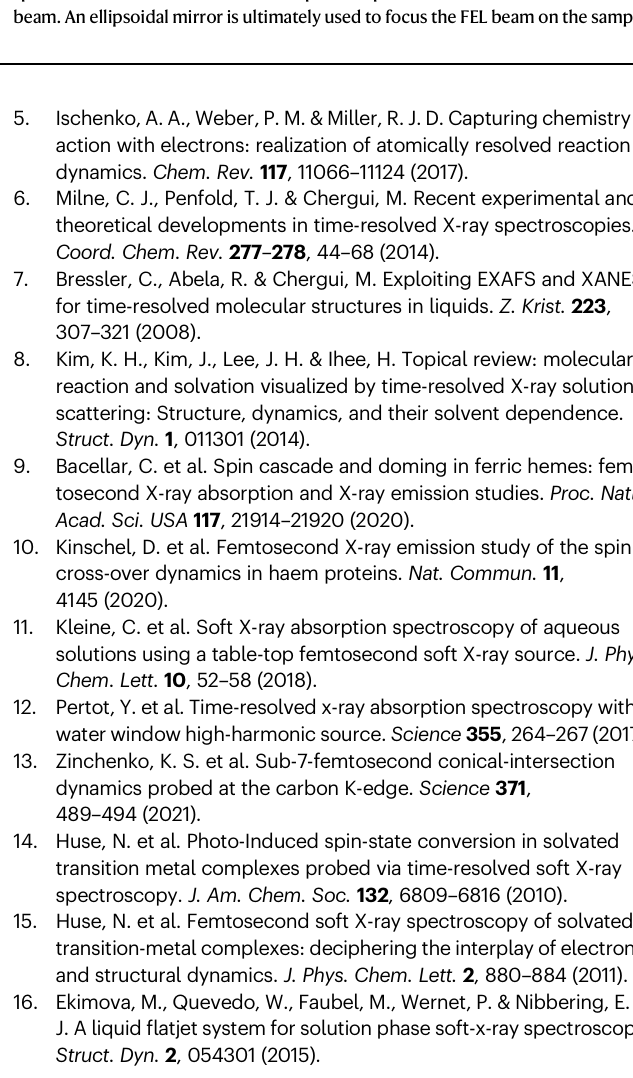
~4.76eV pulse that initiate the Free Electron Laser process, as well as a frequency- tripling (THG) to generate the 4.7eV pump pulse. The seeded electron bunch is propagated through a chain of apple II undulators, allowing control of the polar- ization and energy of the soft X-ray photons. An ionization chamber (IOM) and a spectrometerareusedtorecordonapulse-to-pulsebasethecharacteristicsofFEL